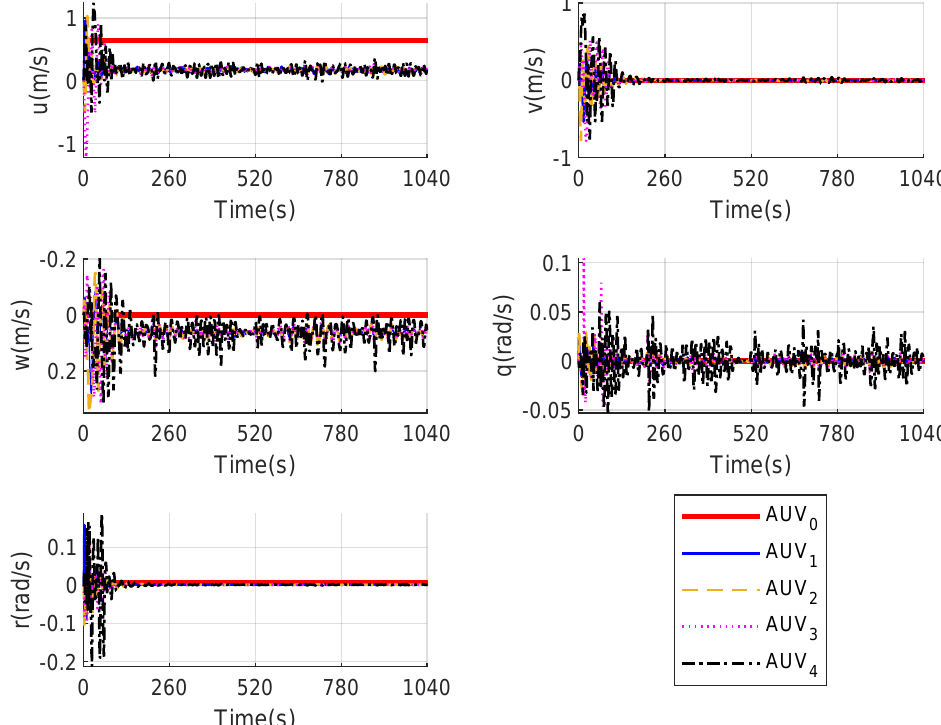
Figure 17. Velocity states of multi-AUV under alterable communication topology with